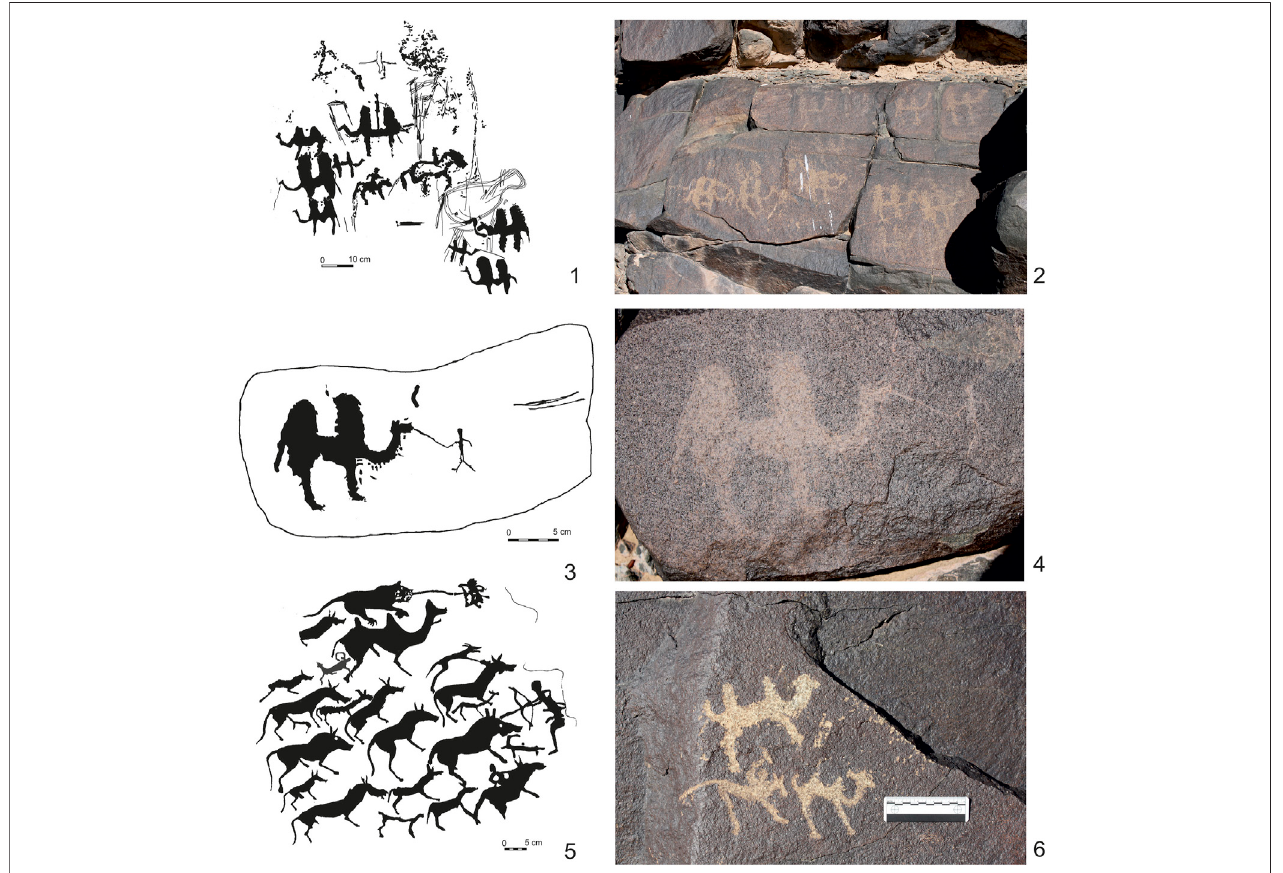
FIGURE 7 | Bronze Age camel petroglyphs in the Gobi Desert: 1 – 4 – Ikher Gashuun, Noyon County, Ömnögovi Province; 5 – Bichigtiyn-am, Bayanlig sum, Bayankhongor Province; 6 – Zamyn Baruun Barsgai, Noyon County, Ömnögovi Province.